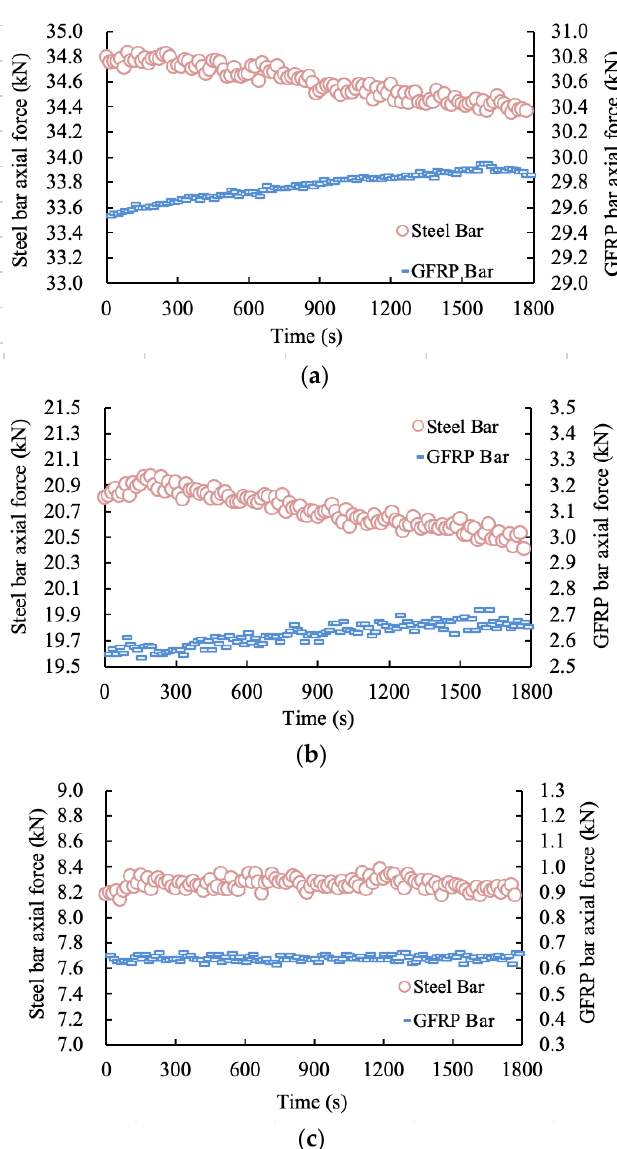
Figure 10. Strain-time curve of each point of the bar body under constant load 150 kN. ( a ) Anchorage depth at 0.75 m away from the zero point. ( b ) Anchorage depth at 1.25 m away from the zero point. ( c ) Anchorage depth at 1.75 m away from the zero point